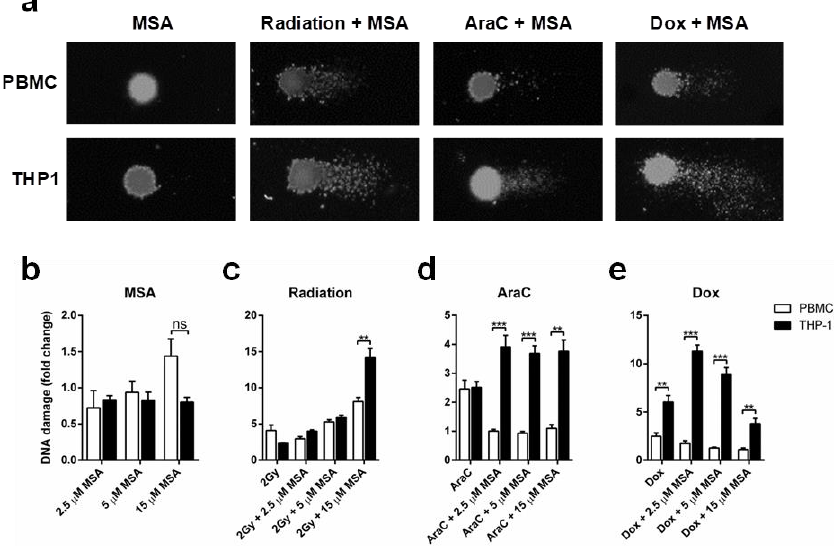
Figure 4. Selenium protects normal cells from DNA damage while enhancing DNA damage in malignant cells. ( a ) Representative image of comet assay (400× magnification) in PBMCs and THP1 cells treated with MSA alone or MSA in combination with radiation, AraC or Dox; ( b ) Quantification